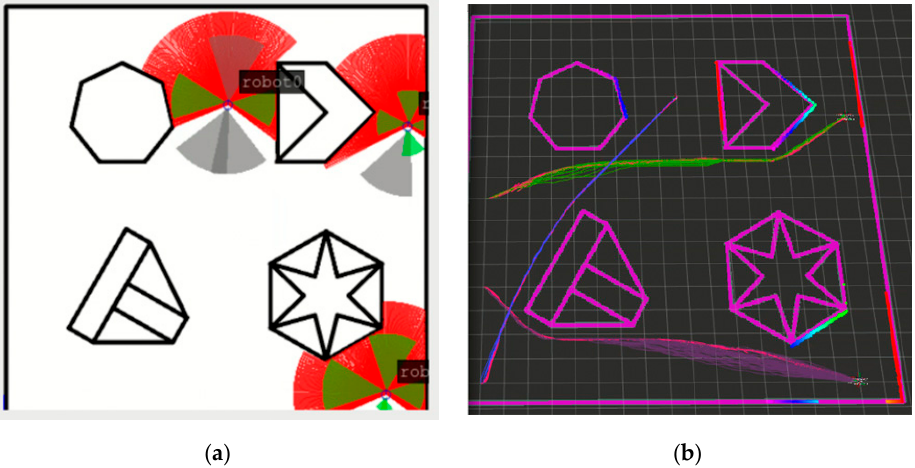
Figure 7. ( a ) The robots reached the target points; ( b ) the final paths of the three mobile robots.